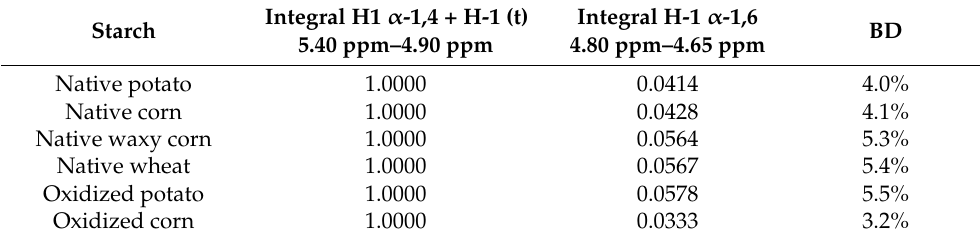
Figure 3. 1 H-NMR of the starch samples in DMSO-d6 and D 2 O at 500 MHz and 25 °C with assignments: H-1 either from α -1,4 (H-1 (1–4) ), -1,6 (H-1 (1–6) ) glycosidic linkage or terminal unit (H-1 (t) ), H-2–H-5 hydrogens along glucose ring, and H-6 for CH 2 OH. Native potato starch shown in blue, native corn starch in red, native waxy corn starch in orange, native wheat starch in green, oxidized potato starch in light blue, and oxidized corn starch in pink. Respective signals between 4.2 and 3.9 ppm corresponded to H 2 O and signals at 2.5 ppm to DMSO. Table 2. Calculated degree of branching (BD) (see Equation (1)) for the different starch samples and the values for the respective integrals used for calculation. The respective spectra are shown in Figure